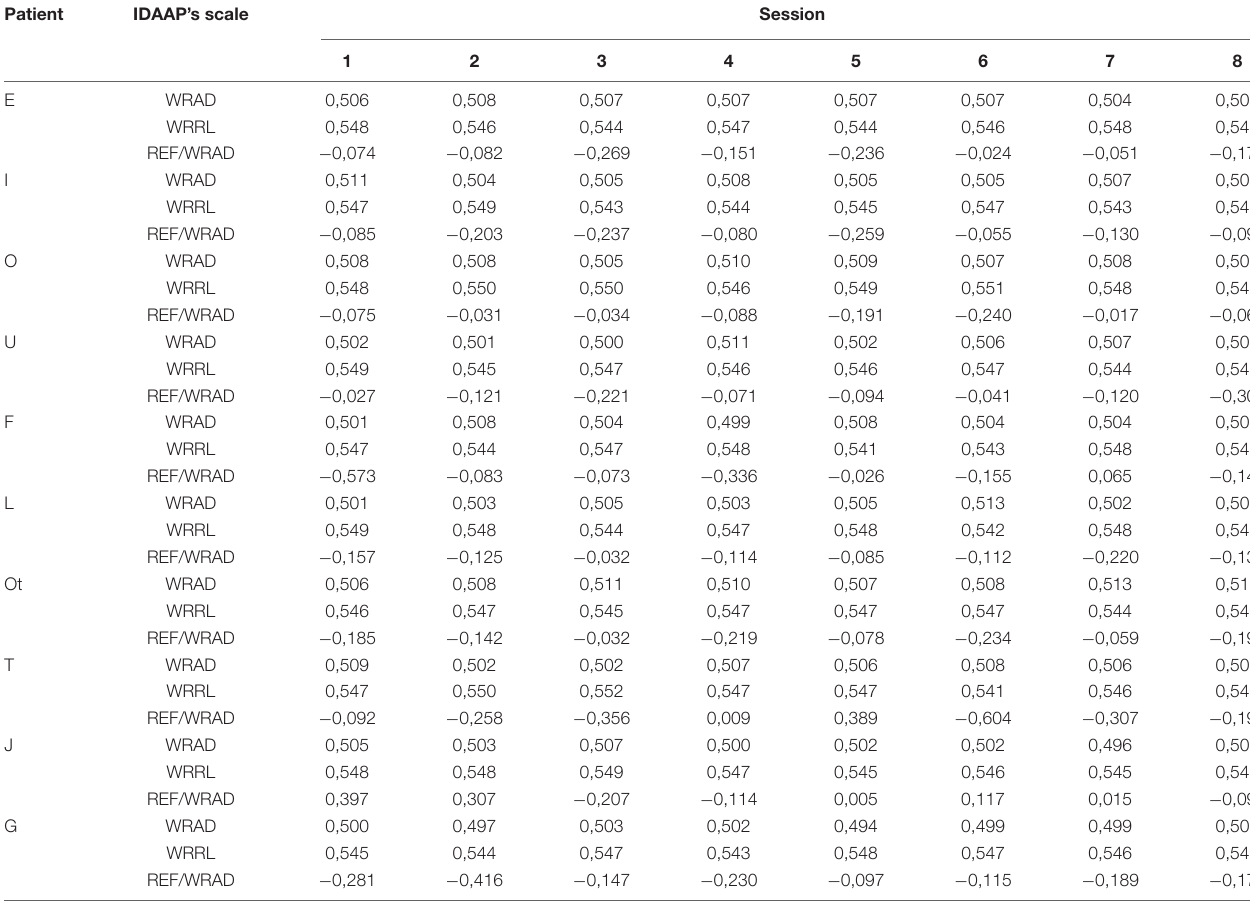
TABLE 6 | IDAAP data.